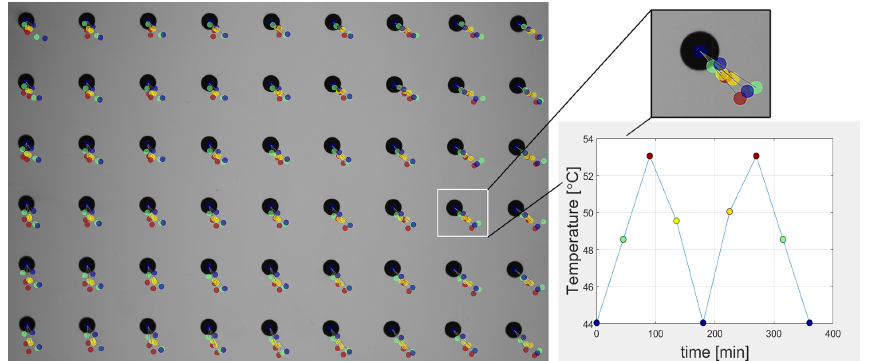
Figure 6. The image drift (multiplied × 100) observed during changes in the ambient temperature and the temperature measured by the internal camera